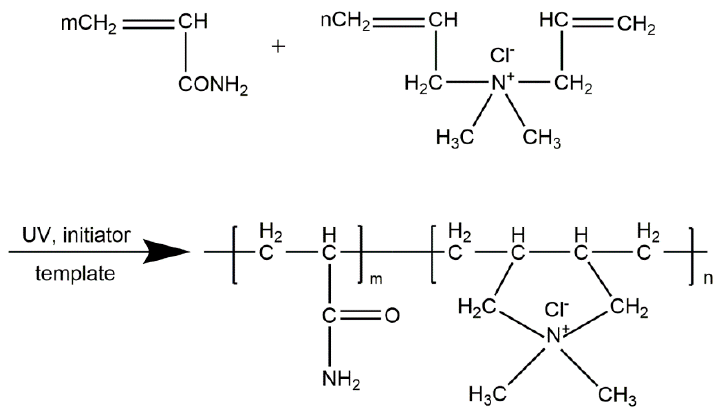
Figure 1. Possible reaction to synthesize CPAM.